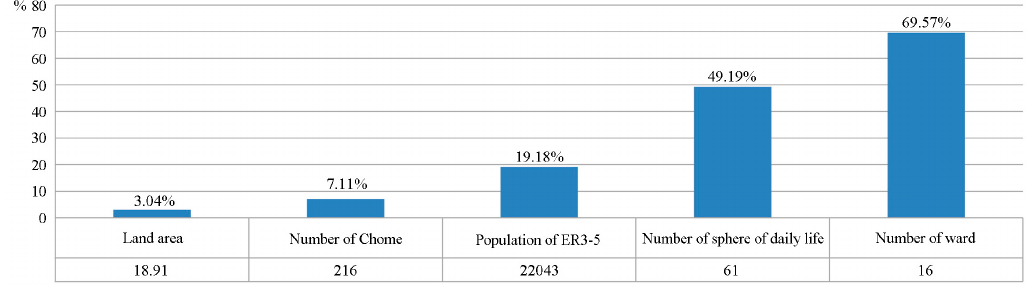
Figure 8. Related statistics for the highest degree of BNIS.